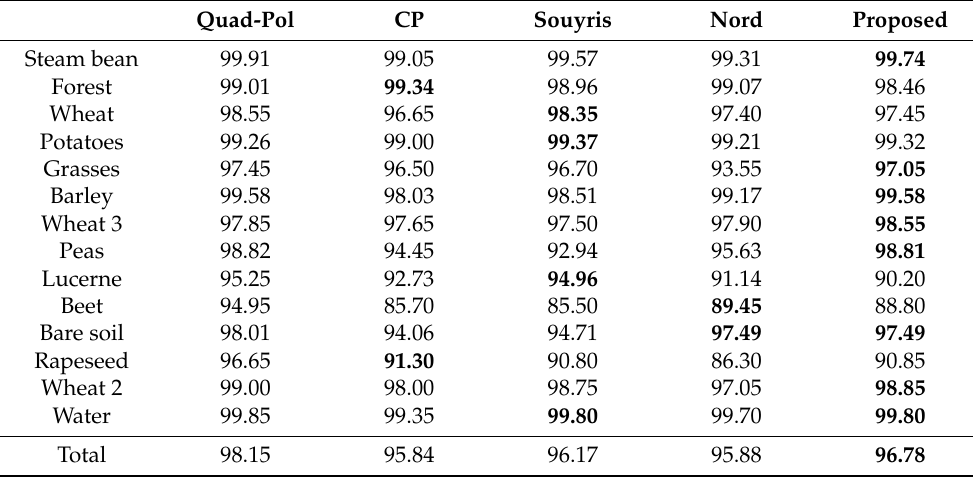
Figure 13. Classification of entire image. ( a ) Quad-pol data. ( b ) CP data. ( c ) Pseudo-quad-pol data from Souris’ model. ( d ) Pseudo-quad-pol data from Nord’s model. ( e ) Pseudo-quad-pol data from proposed model. Table 4. CV-CNN classification rates (%) of quad-pol data, CP data, and reconstructed data.